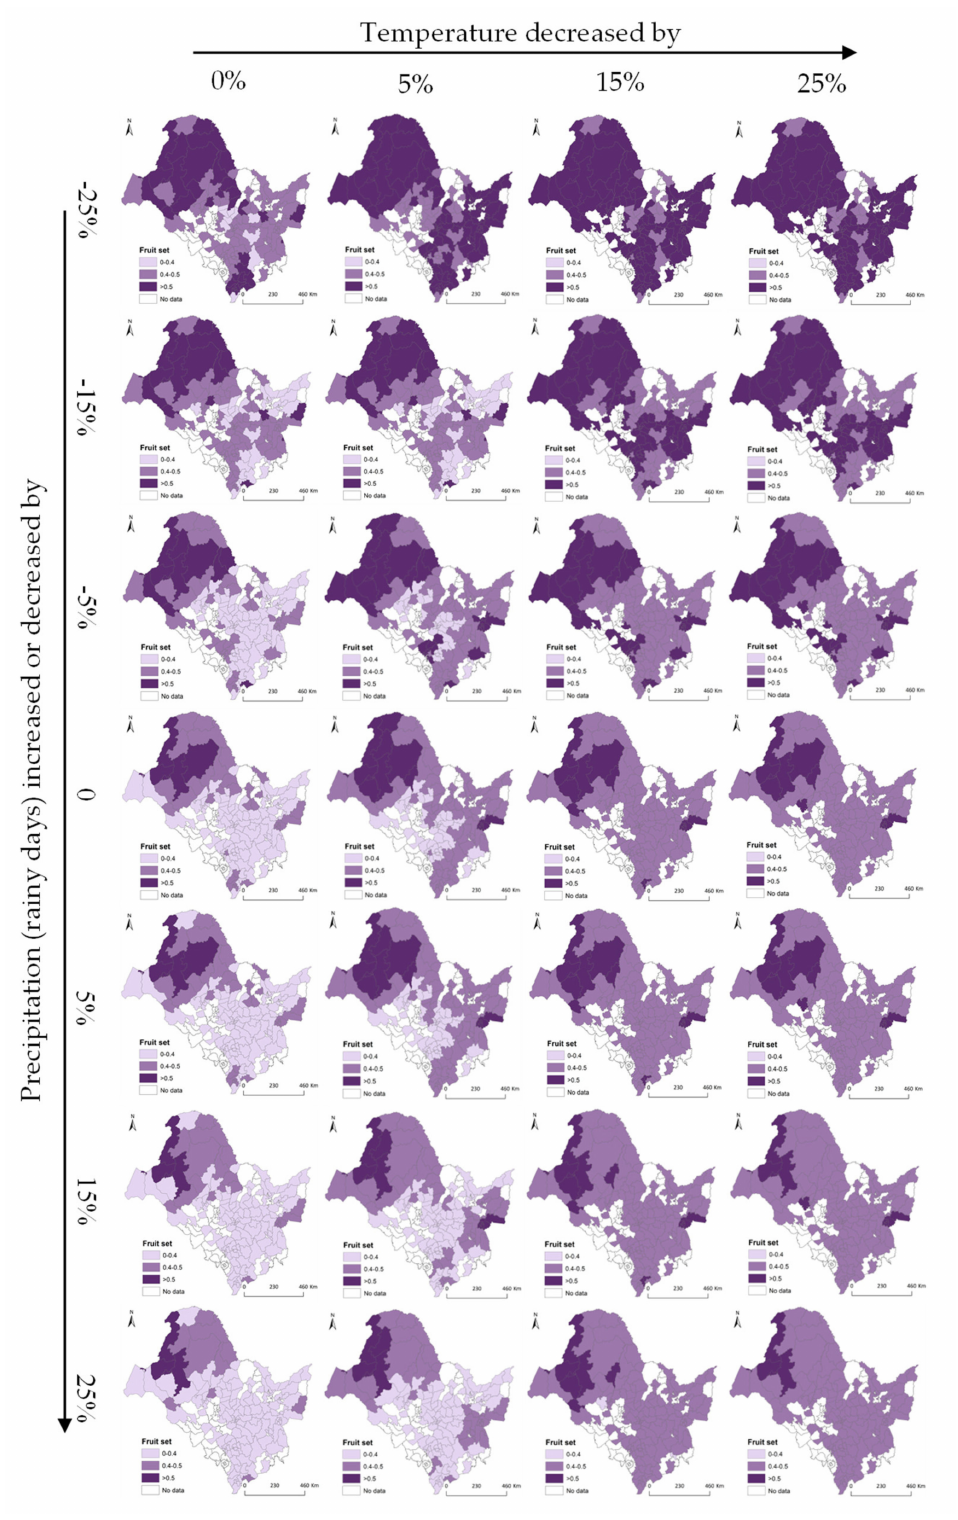
Figure 10. Fruit-set predictions in 151 bog blueberry growing regions in Northeast China with decreased temperatures and